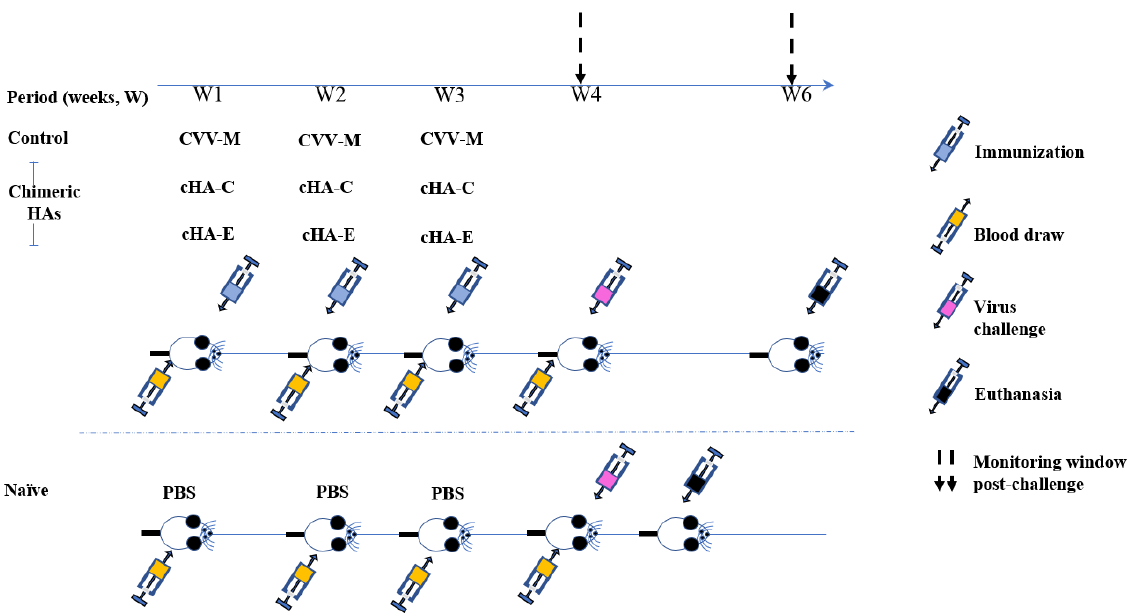
Figure 1. A schematic mice immunization and challenge regimen.